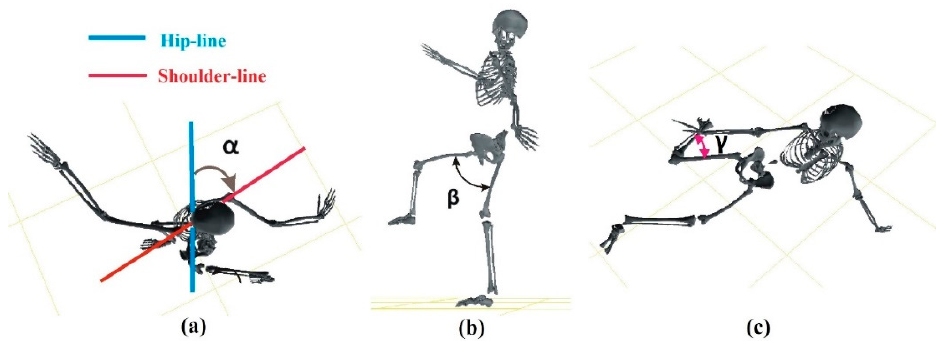
Figure 5. Key/dominate factors influencing kick quality: ( a ) X-factor α (top view); ( b ) Take-off angle between thighs β (side view); ( c ) Minimum KS knee angle γ (top-front view).